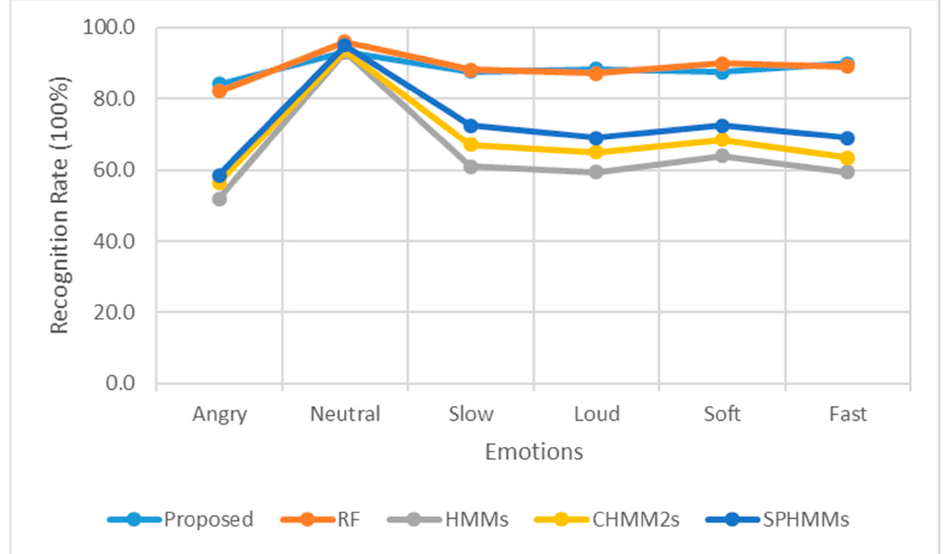
Figure 8. Comparison of the Emotion Recognition rate attained by the proposed algorithm, Random Forest Classifier model, HMMs, CHMM2s and SPHMMs using the SUSAS dataset. Table 4. Performance study of various methods utilizing the SUSAS dataset.